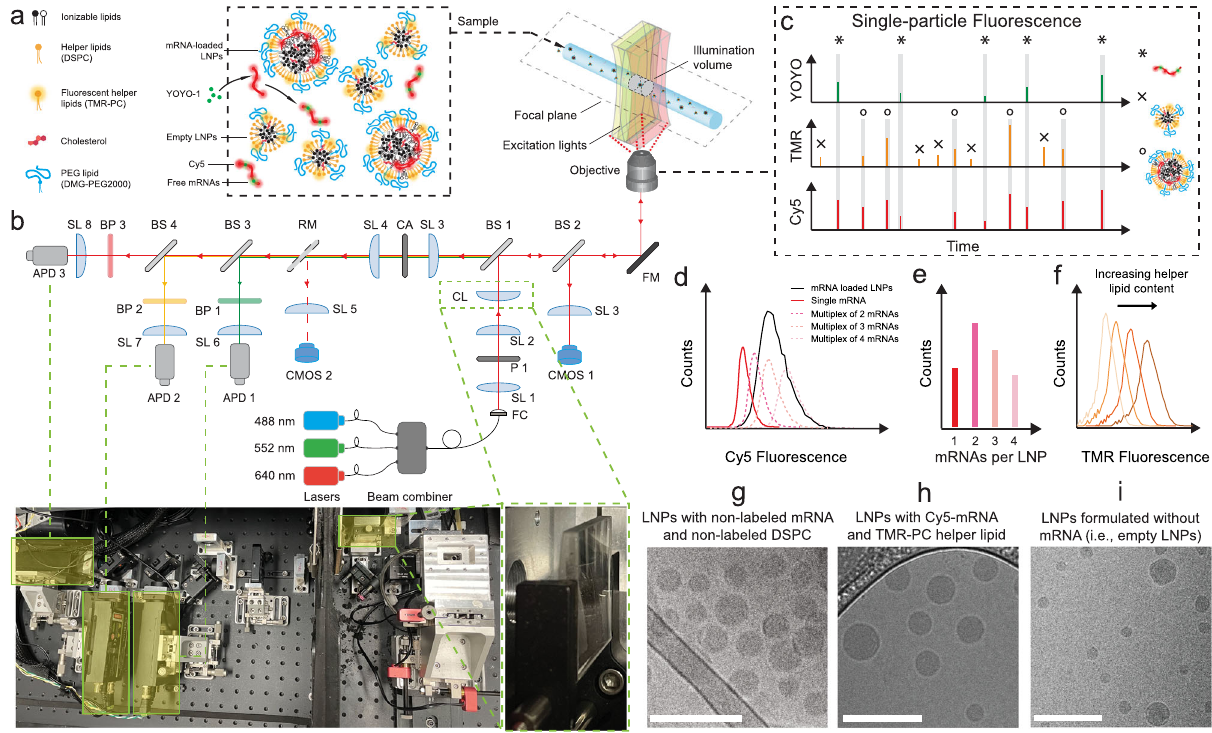
Fig. 1 | Instrumentation of multi-color CICS platform, methodology for char- acterization of LNP formulations. a Species of interest in LNP formulations include the mRNA-loaded LNPs, empty LNPs, and free mRNAs. Three fl uorescent tags were used for the single-particle fl uorescence detection and species classi fi - cation:allmRNAshaveCy5tags;5%ofthehelperlipidscarryaTMRtag;YOYO-1was added into the LNP sample prior to CICS assessment to stain-free mRNAs. b Instrumentalsetupofthree-colorCICS.Thelaserswere fi